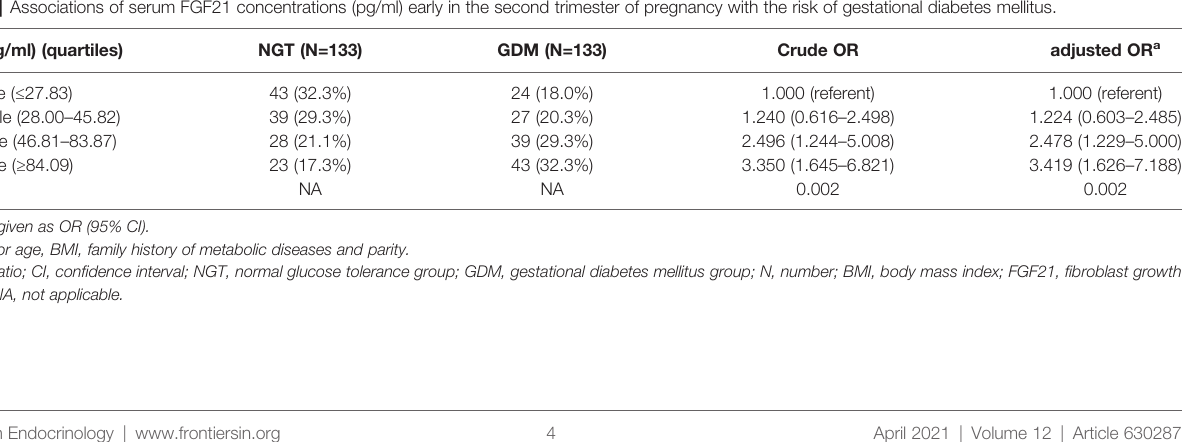
TABLE 1 | Baseline characteristics of the study population and the serum levels of FGF21 in different groups. Total